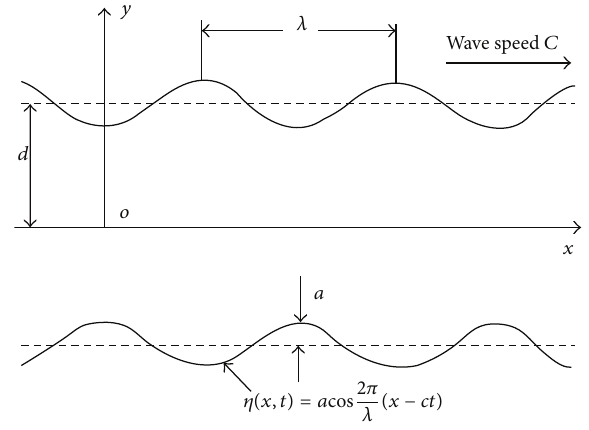
Figure 1: Geometry of the